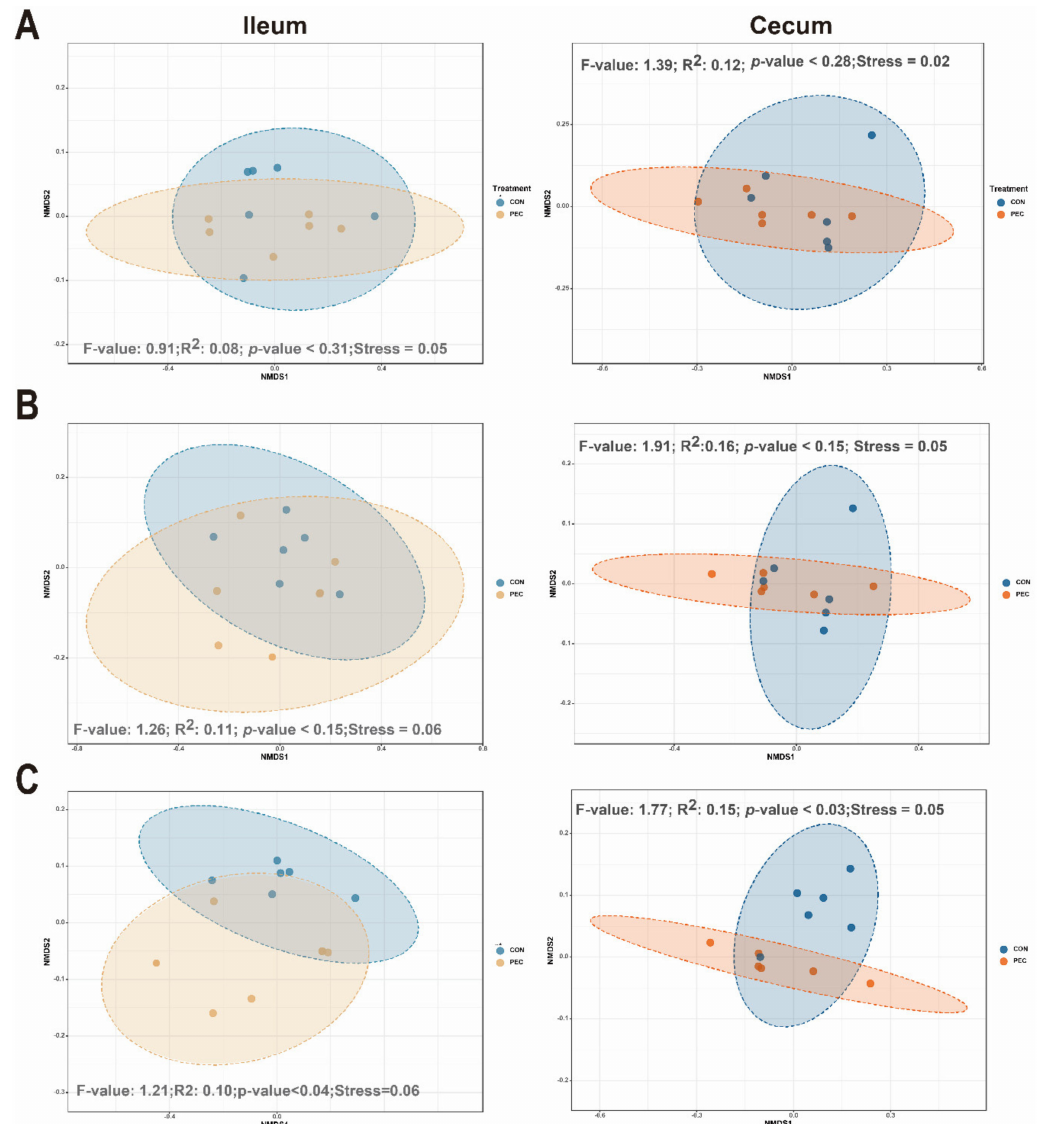
Figure 2. E ff ect of pectin on bacterial community in mucosa of growing pigs. Distances created with weighted-Unifrac distance show ileal or cecal mucosa at di ff erent taxonomy levels: Phylum ( A ), Family ( B ) and Genus ( C ). The p -value represents diet di ff erences among NMDS scores along component 1. CON, control; PEC,